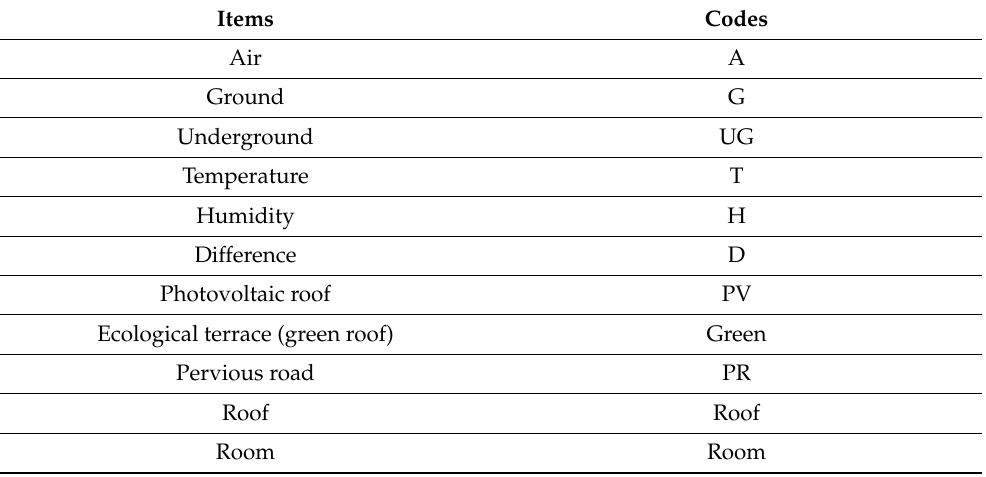
Figure 6. Historical data search in the campus green data monitoring system. Table 4. Sensor location